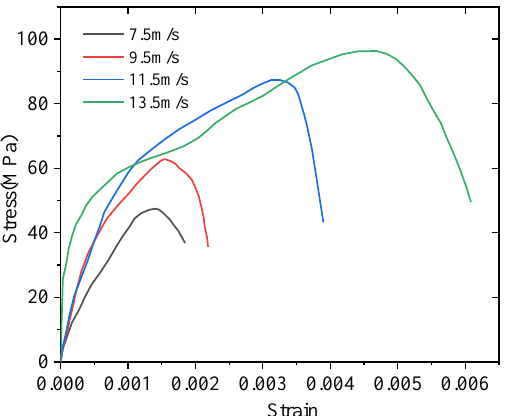
( d ) Figure 22. The simulation results of the specimen failure process. ( a ) Stress wave acting on the specimen. ( b ) Propagation of the stress wave to the specimen. ( c ) Sporadic unit failure. ( d ) Overall failure of the specimen. In LS-DYNA, the stress – time history curve and strain – time history curve of the object element can be directly extracted from the calculation results, and the stress – strain curve can be obtained after corresponding the two data points. A summary of the stress – strain curves is shown in Figure 23, which shows that with increasing impact velocity, the